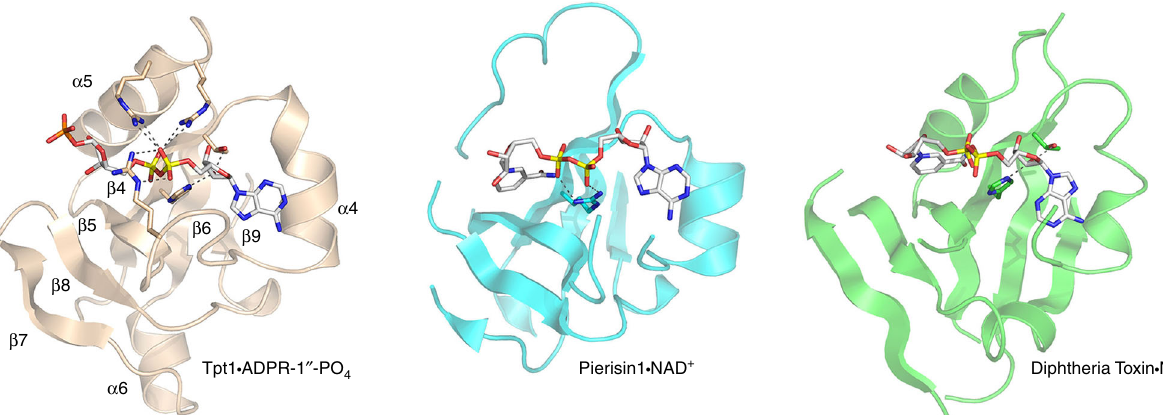
Fig. 5 Homology of the Tpt1 NAD + lobe to ADP-ribosylating toxins. A side-by-side alignment of the homologous segments of the Tpt1 (cid:129) ADPR-1 ″ -PO 4 (beige), Pierisin1 (cid:129) NAD + (pdb 5H6J, cyan), and diphtheria toxin (cid:129) NAD + (pdb 1TOX, green) structures is shown. The ligands are depicted as stick models with gray carbons. Amino acid contacts to the ADP-ribose moieties are indicated by